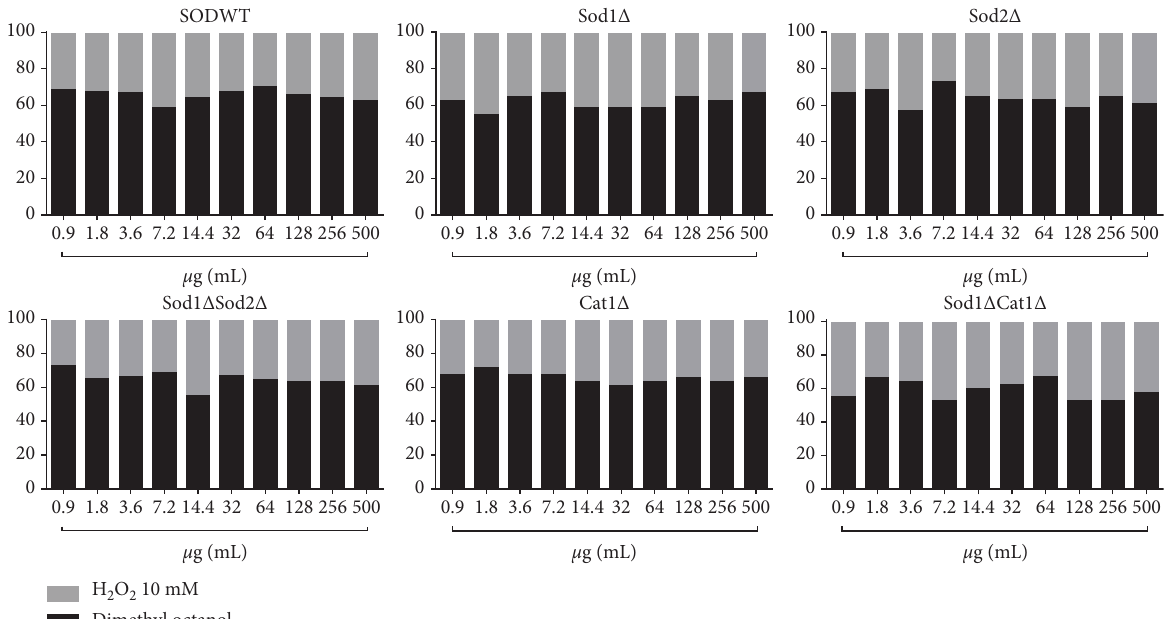
Figure 8: Modulatory efect of 3,7-dimethyl-1-octanol in oxidative damage induced by hydrogen